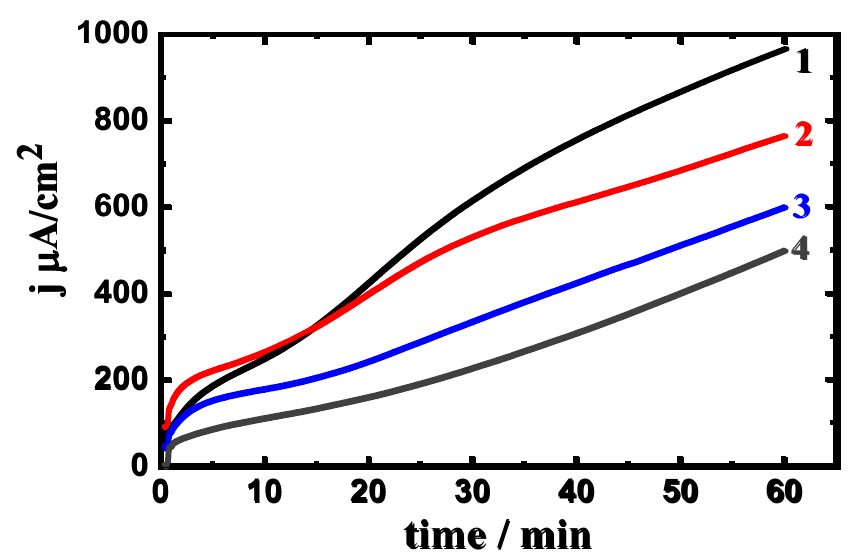
Figure 8. Current curves collected at − 475 mV (Ag/AgCl) for iron in 3.5% NaCl solutions containing (1) 0.0, (2) 5 × 10 −5 , (3) 1 × 10 −4 , and (4) 5 × 10 −4 M HAO after 1 h immersion.